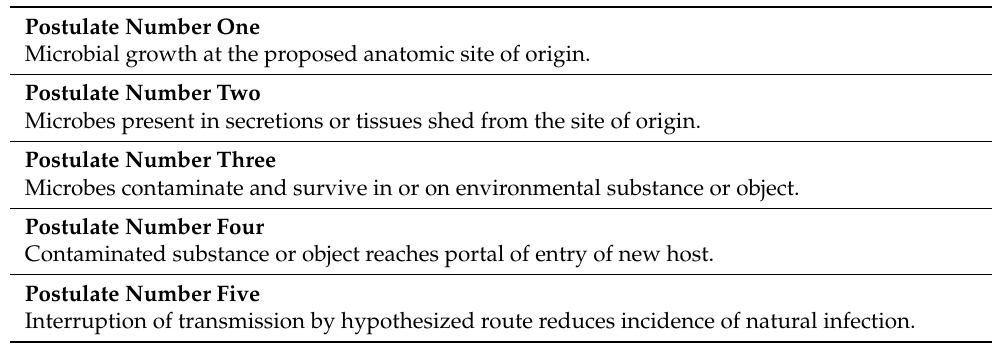
Table 3. Gwaltney’s and Hendley’s proposed postulates for respiratory virus transmission